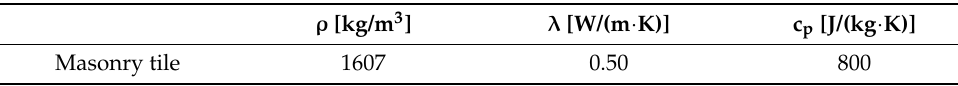
Table 5. Estimated thermal properties of the masonry tile.